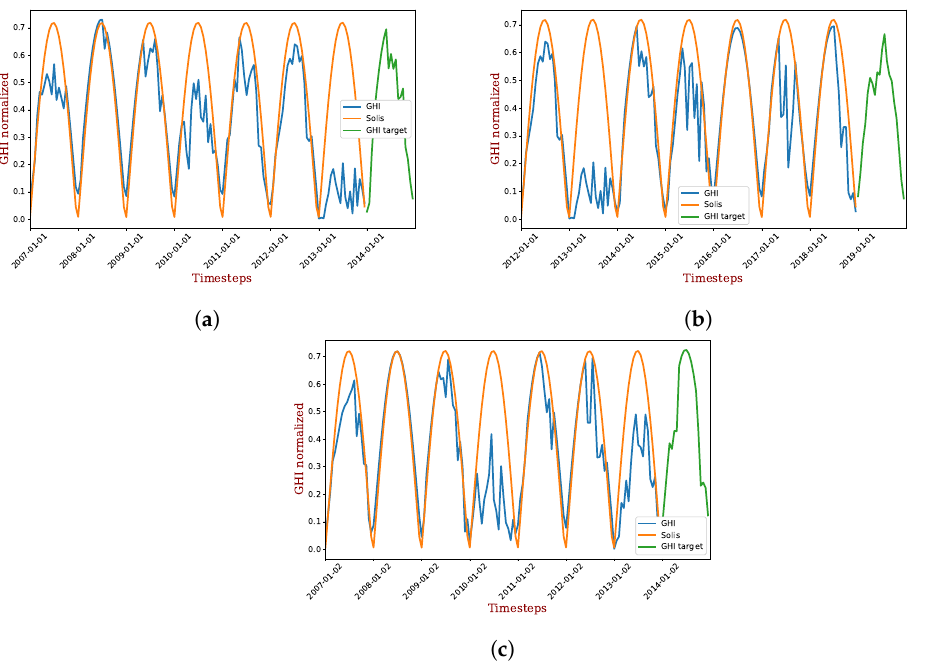
Figure 11. Three different samples to feed RNN model after data preparation [58]. ( a ) First sample in the training set. ( b ) Sample 101 in the training set. ( c ) Sample 102 in the training